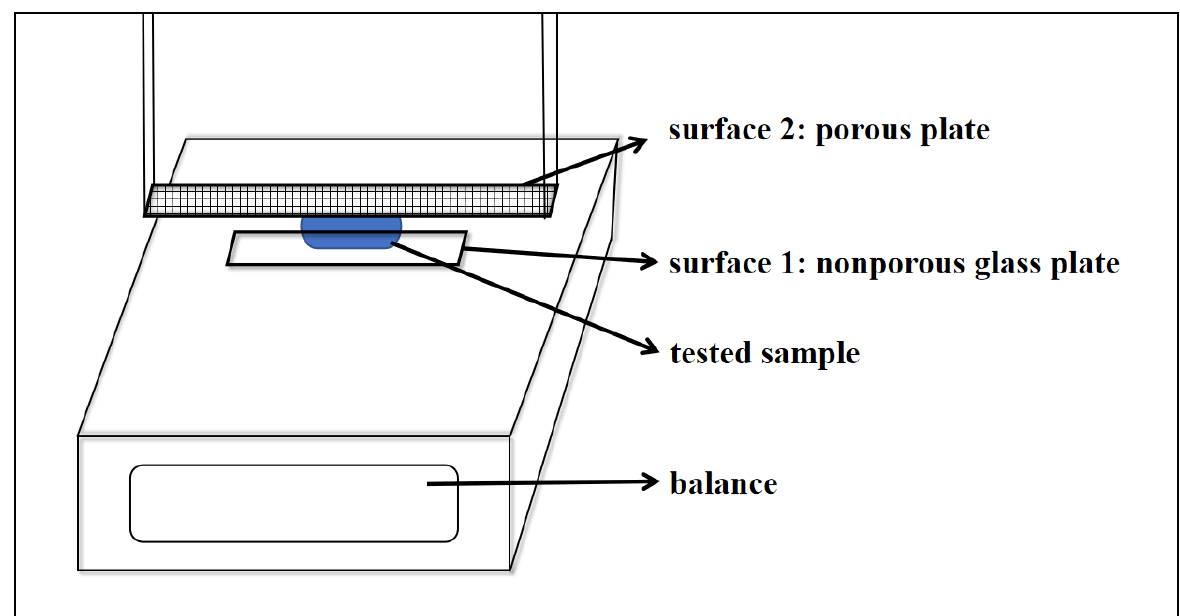
Figure 4. Diagram of experimental device using double-layer surface contact internal pressure method.